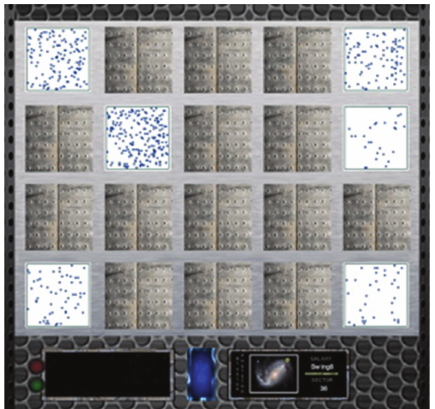
Figure 4: The decision challenge as it appeared in the EMFants